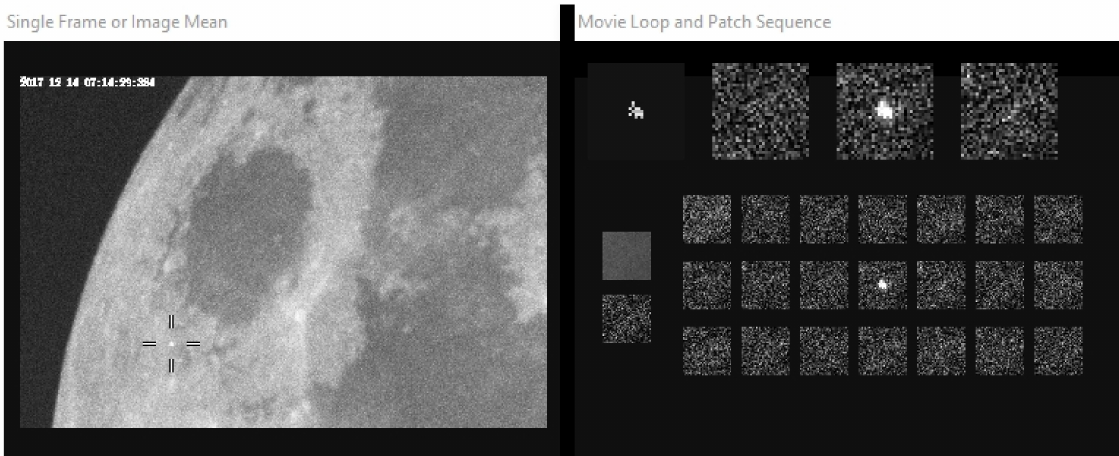
Figure 3. LunarScan windows displaying Flash 2 (recorded only from Macei ó